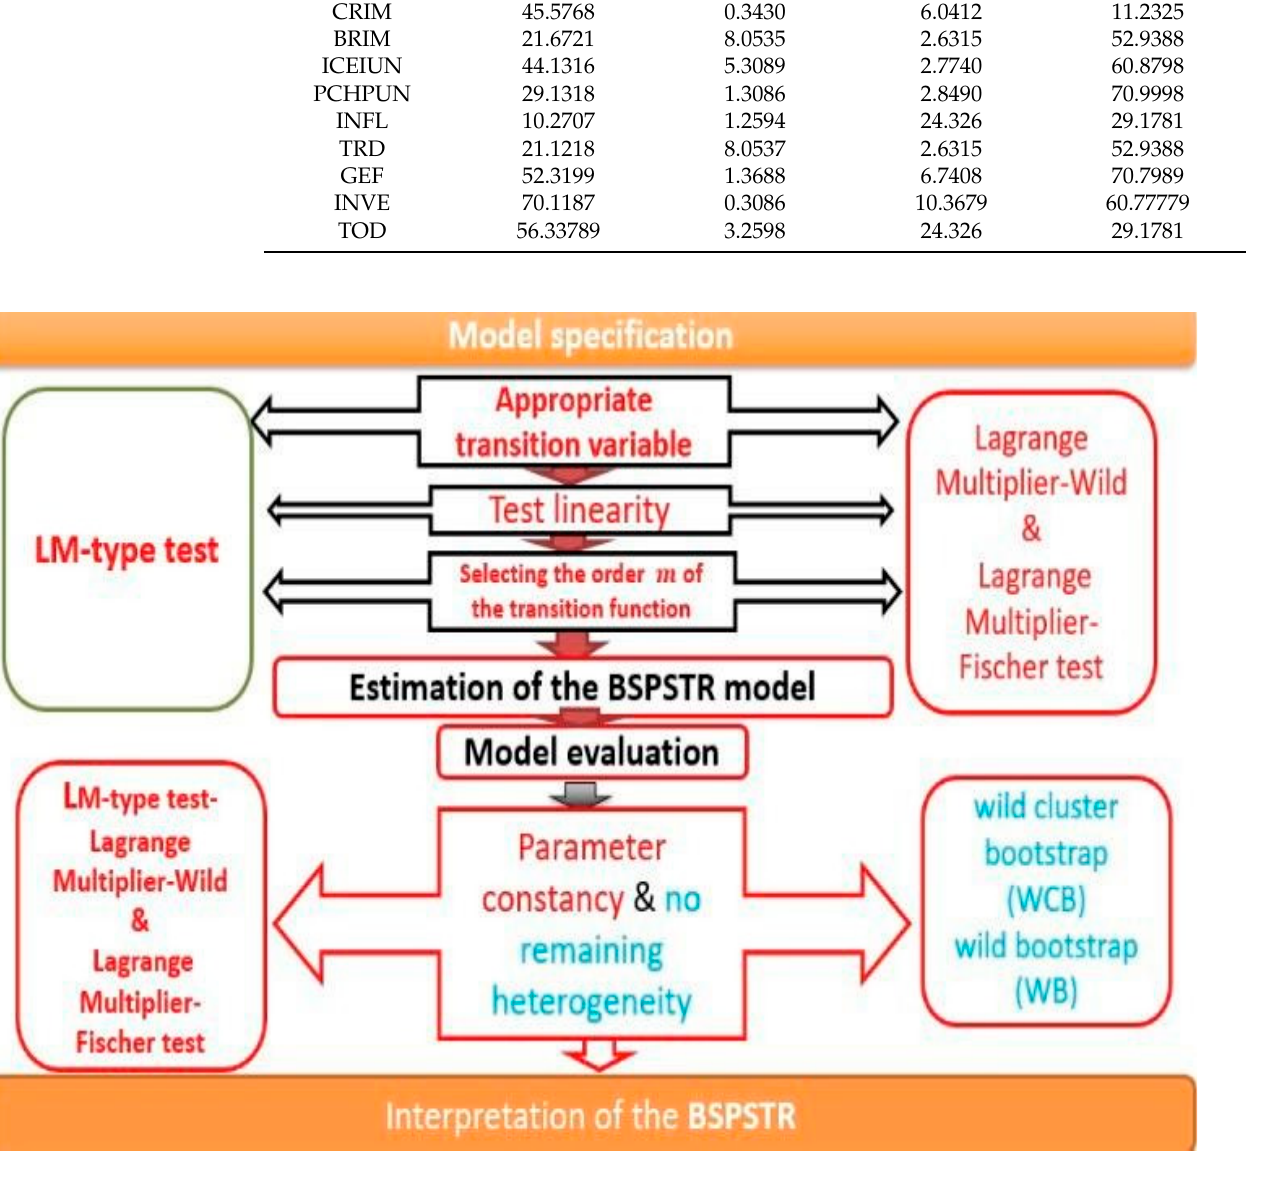
Figure A1. Methodological sequence or structure.